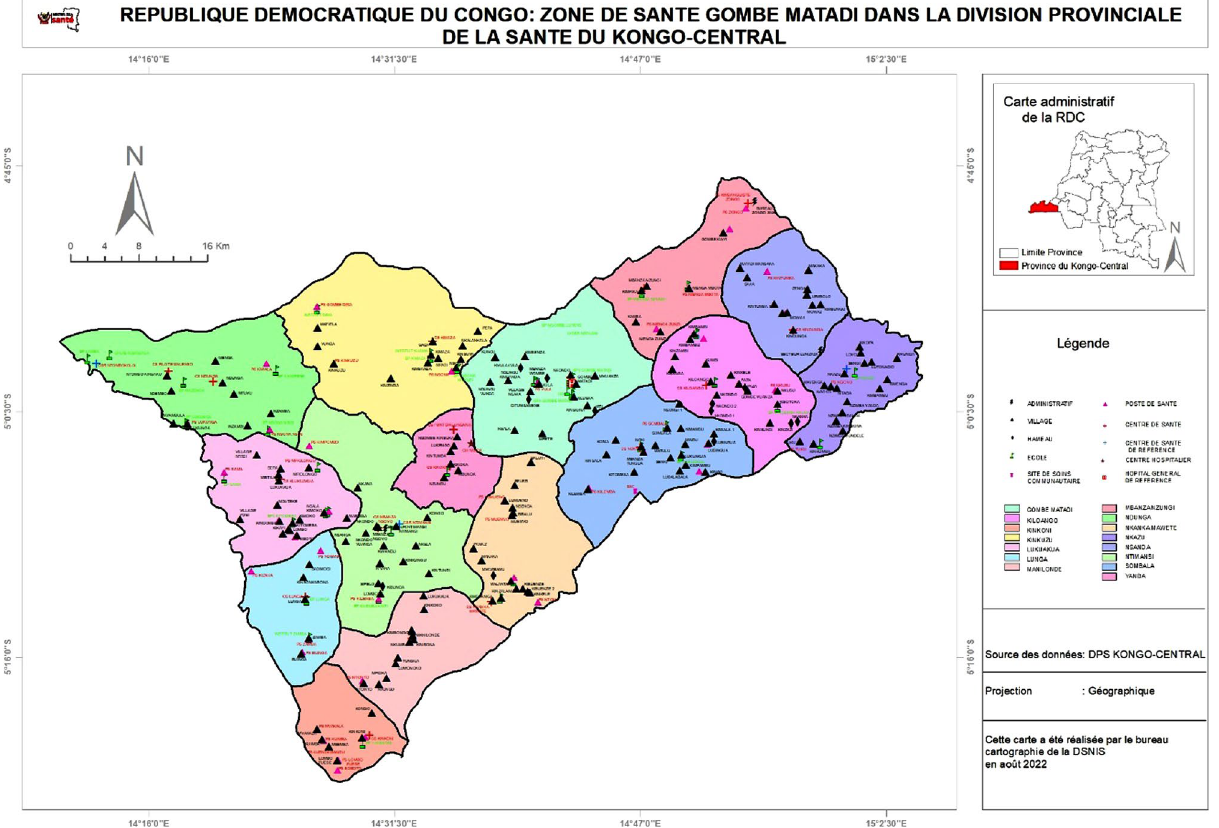
Figure 1. The map of Gombe Matadi Health Zone ( Source : The Health Zone of Gombe Matadi, Software QGIS 3.4 2018, https:// www. qgis.